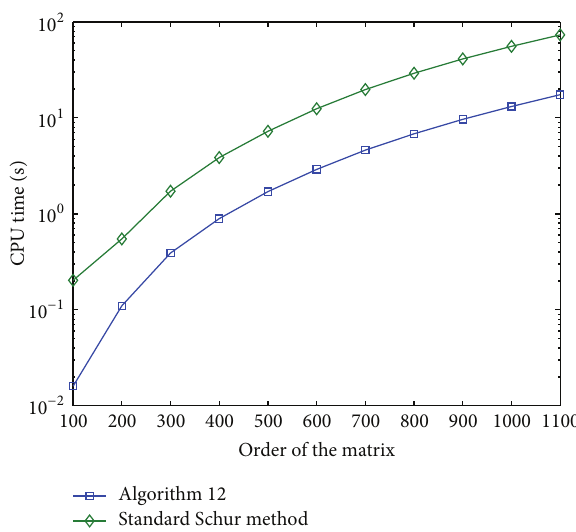
Figure 1: Comparison of the CPU time for Algorithm 12 and the standard Schur method in logarithmic scale.